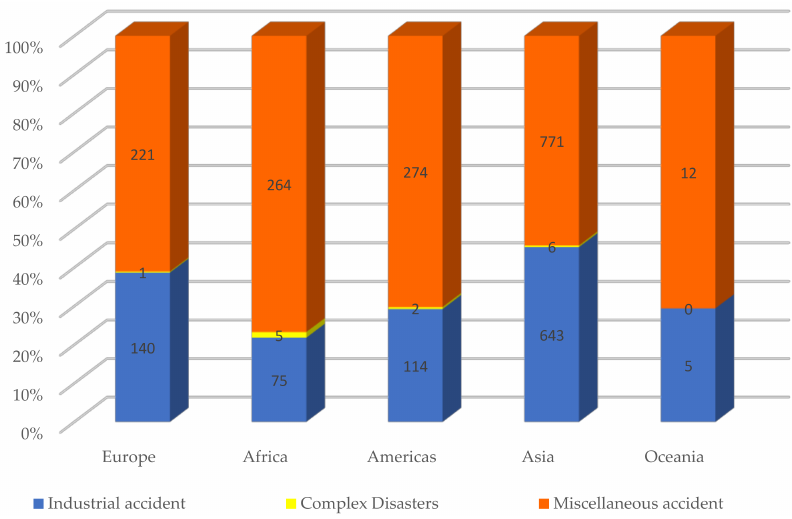
Figure 2. Distribution of disaster type according to the